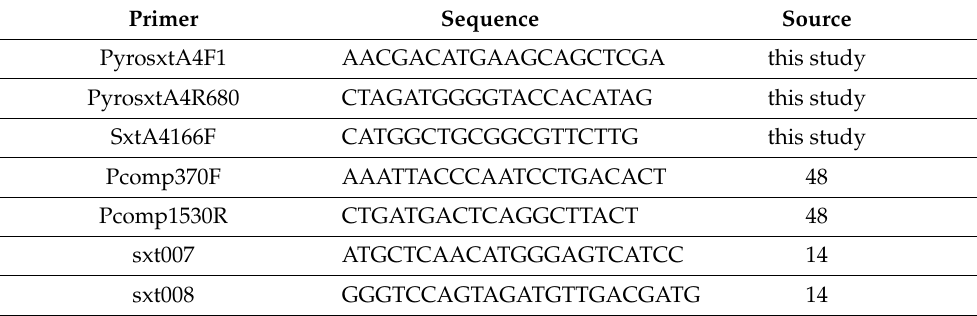
Table 1. List of